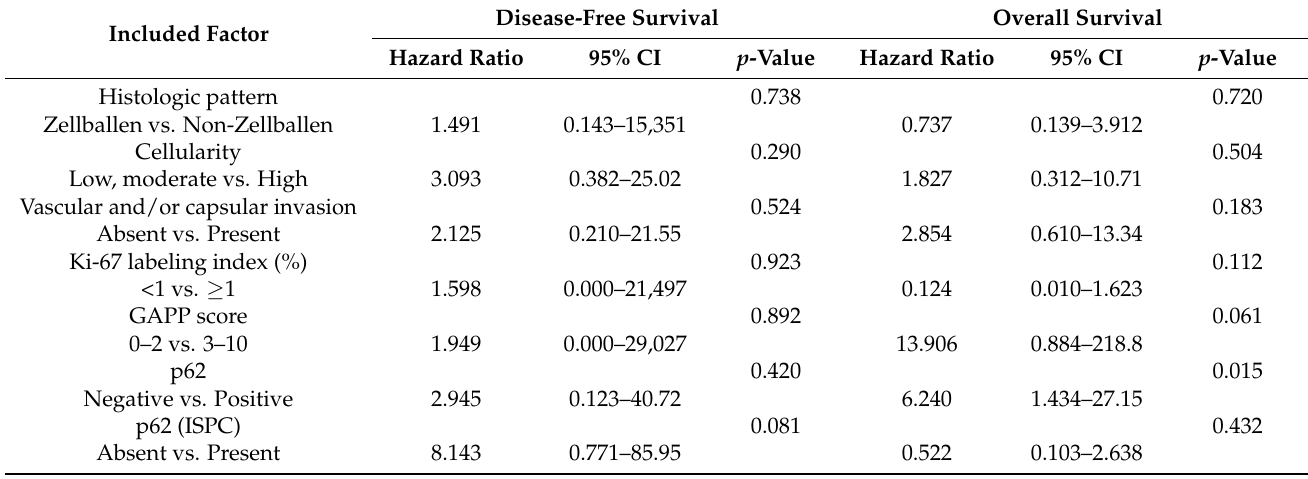
Table 5. Multivariate analysis of disease-free survival and overall-survival of patients with pheochromocytoma.